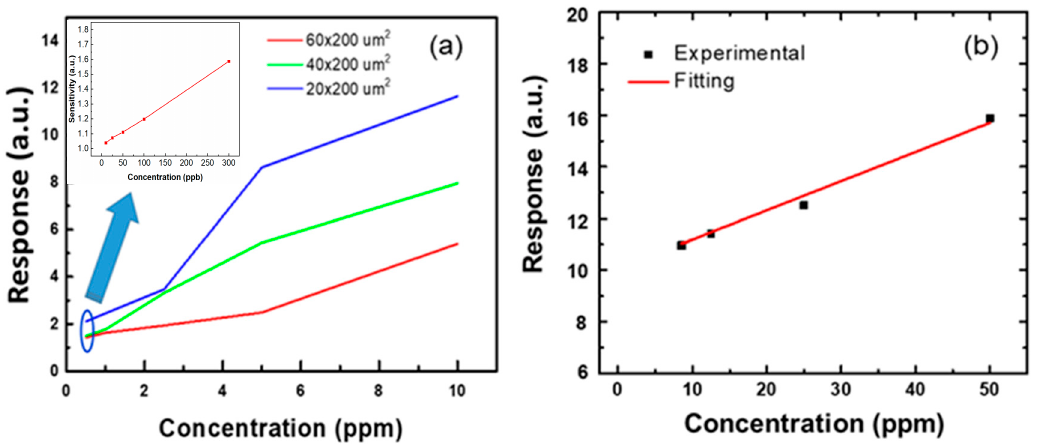
Figure 7. Response of the gas sensor devices as function of ( a ) low NO gas concentration for the gas sensor with different length and ( b ) of high NO gas concentration. Inset of Figure 6a shows the response of ZGO with 20 μ m × 200 μ m as a function of NO gas with ppb concentration.